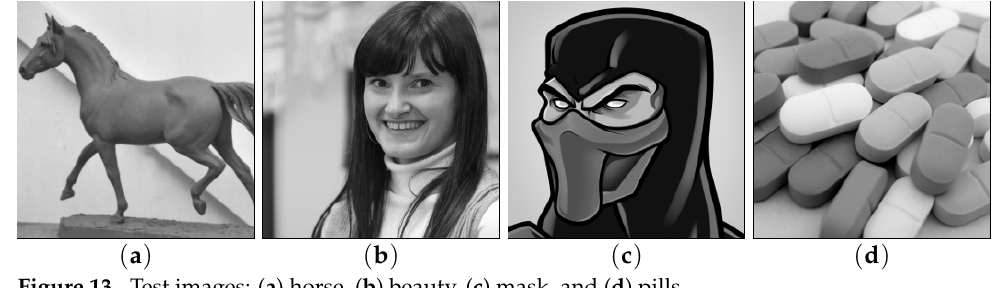
Figure 13. Test images: ( a ) horse, ( b ) beauty, ( c ) mask, and ( d )